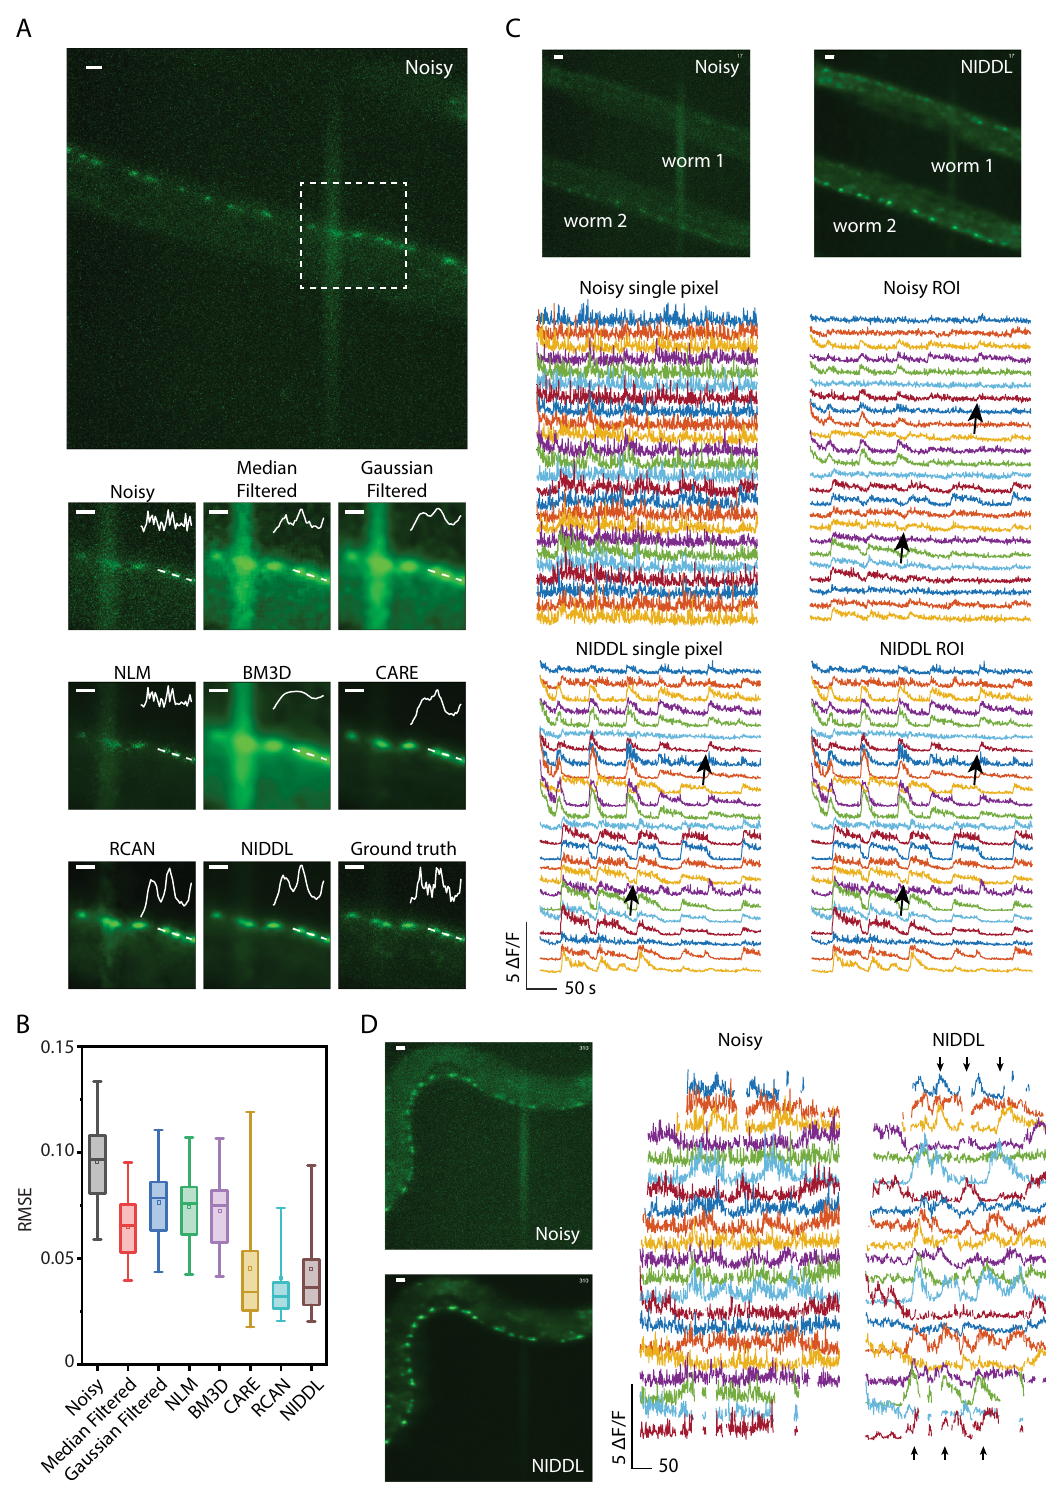
laser power image speci fi es the clean (high SNR) image.